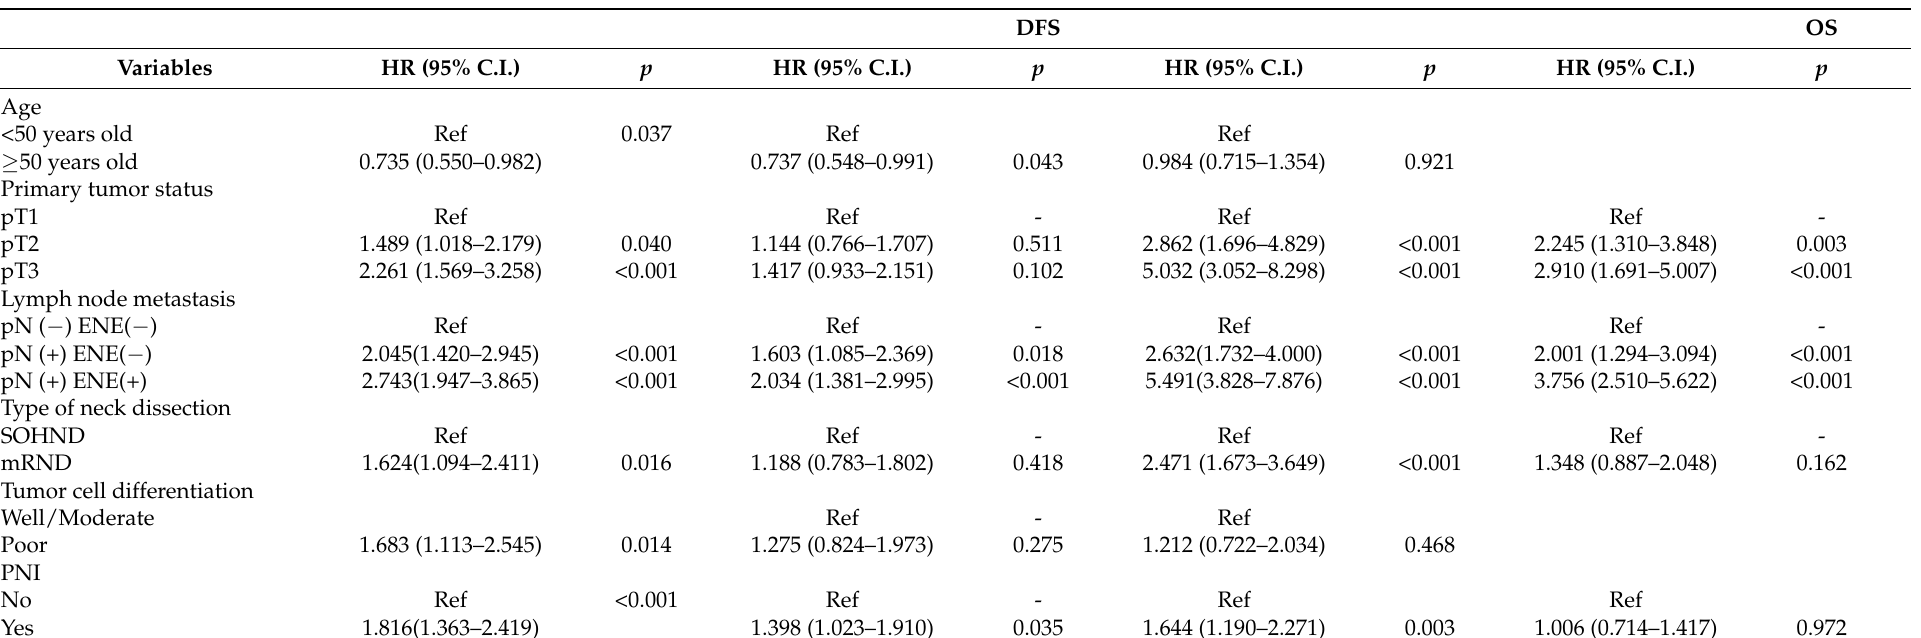
Table 4. Multivariate Cox regression analysis for factors influencing disease-free survival and overall